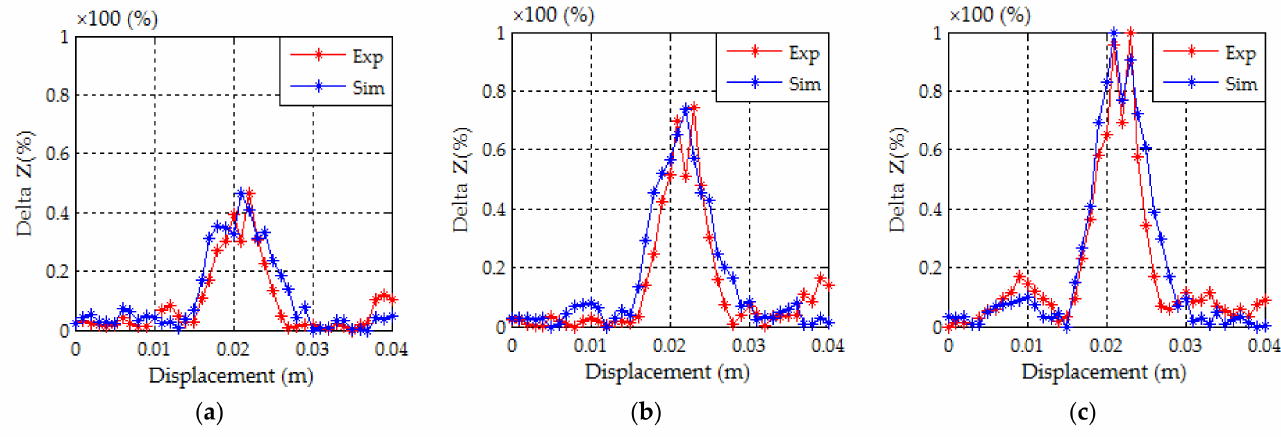
Figure 14. Impedance variation in (%) at 20 kHz with ( a ) depth = 0.3 mm, ( b ) depth = 0.5 mm, and ( c ) depth = 1